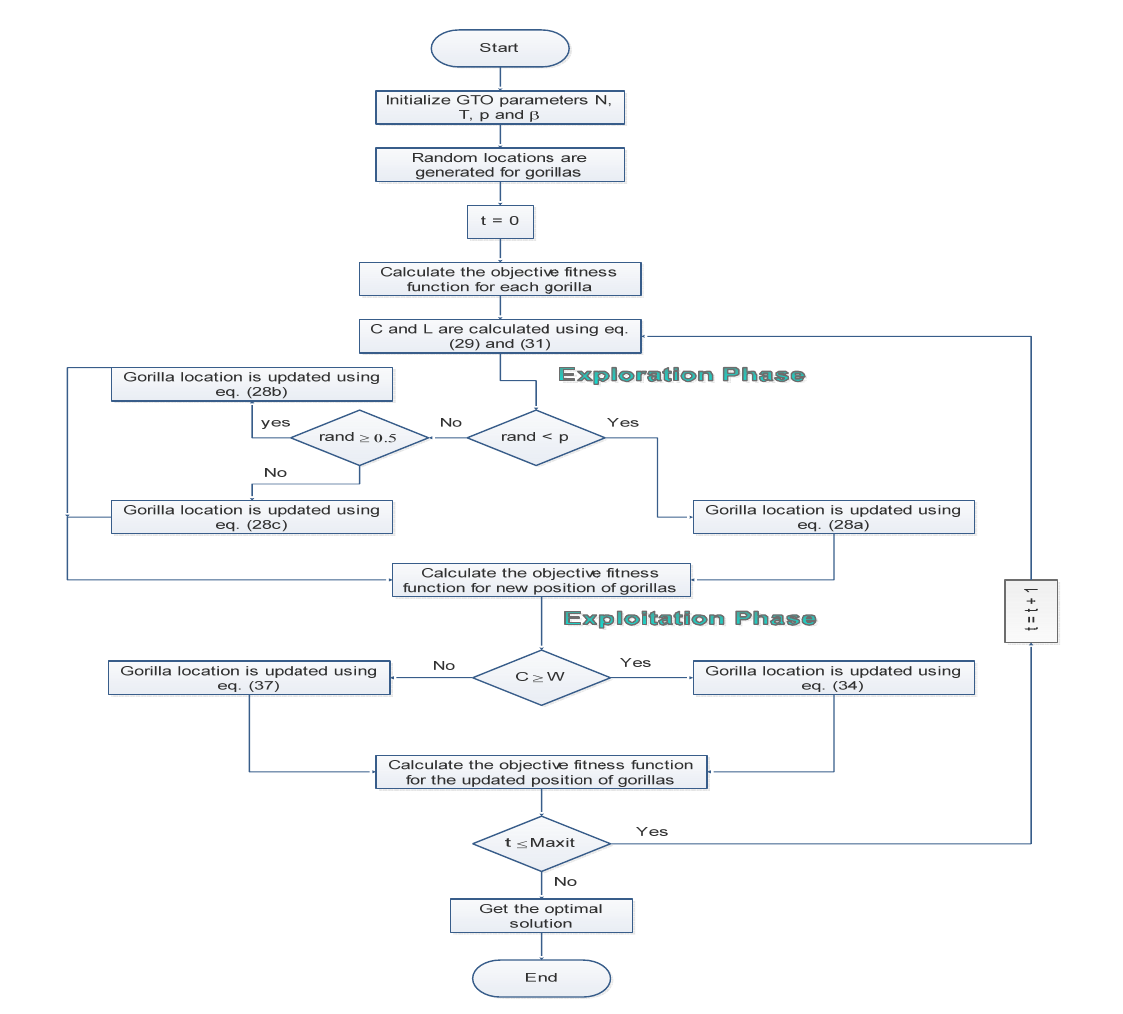
Figure 1. Flow chart of the GTO algorithm to solve the problem of OADG.